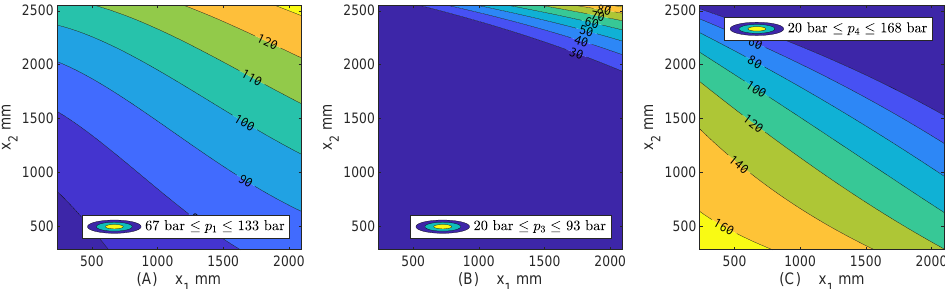
Figure A1. Design pressures over the course of piston strokes for individual chamber